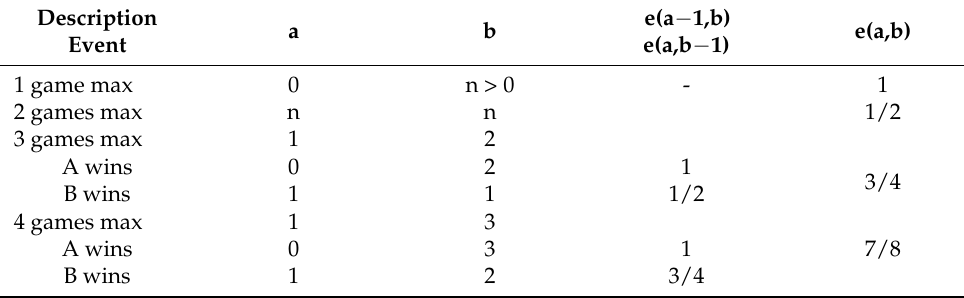
Table 2. Recursive calculus of e(a,b) by Pascal (retrieved from [37]). Description